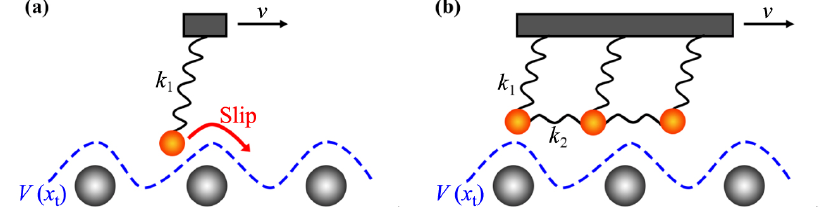
Fig. 2 Atomic friction model: (a) PT model, (b) Frenkel–Kontorova